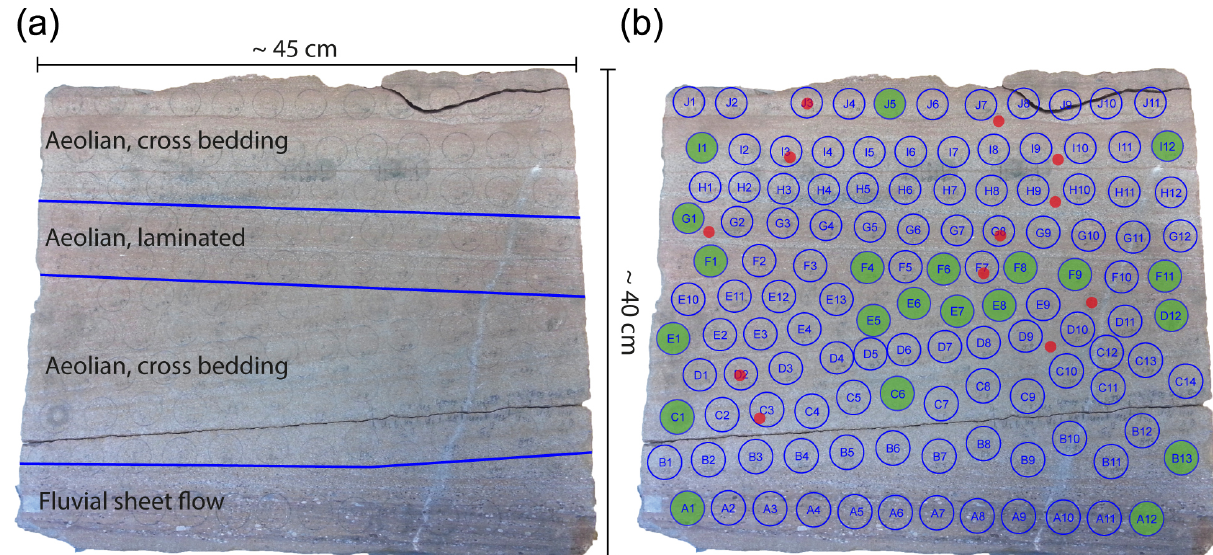
Figure 1. (a) Upper Rotliegend sandstone block showing four main deposition facies. (b) Sampling locations and sizes of the extracted plugs (green) and the mini plugs (red)